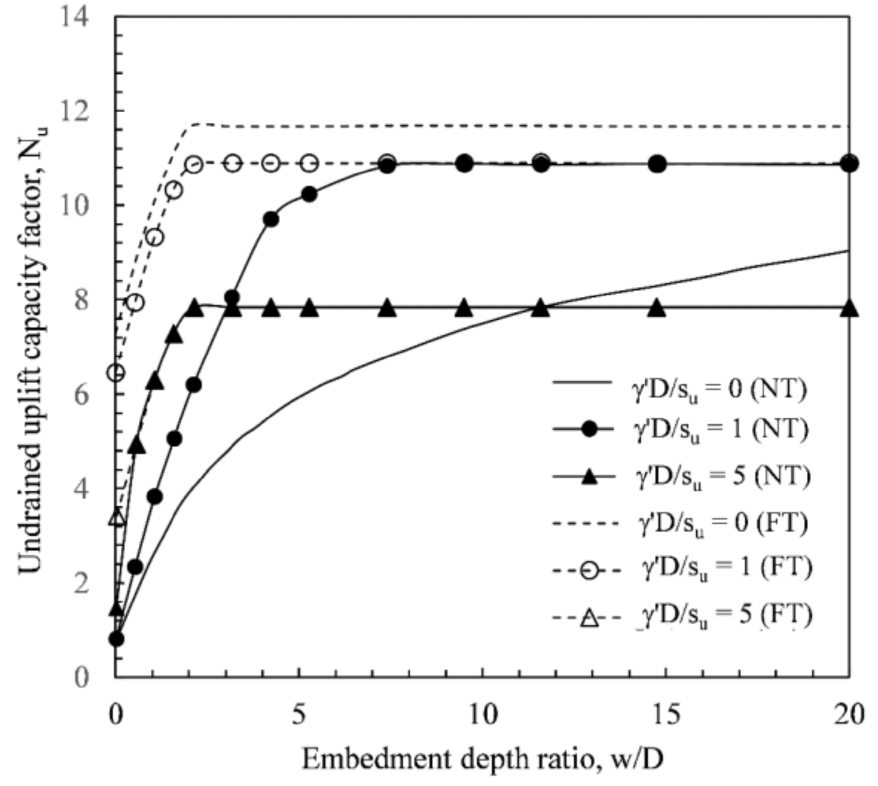
Figure 13. Variation of uplift resistance with soil cover depth and soil unit weight for both NT and FT conditions and for rough pipeline surface